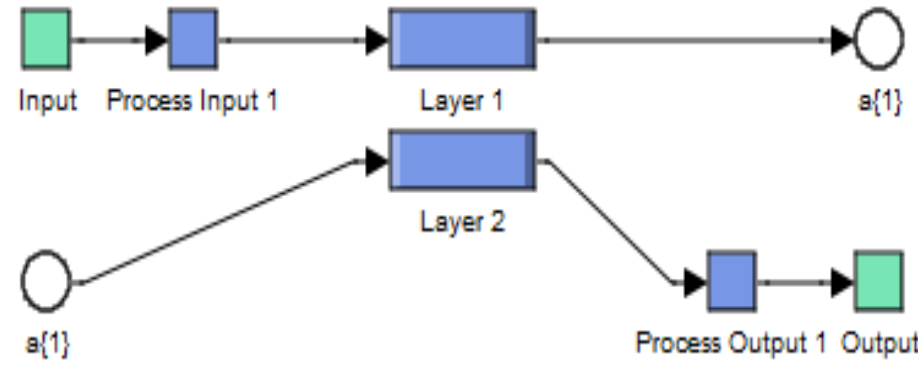
Figure 5. Structure of ANN hysteresis comparators.